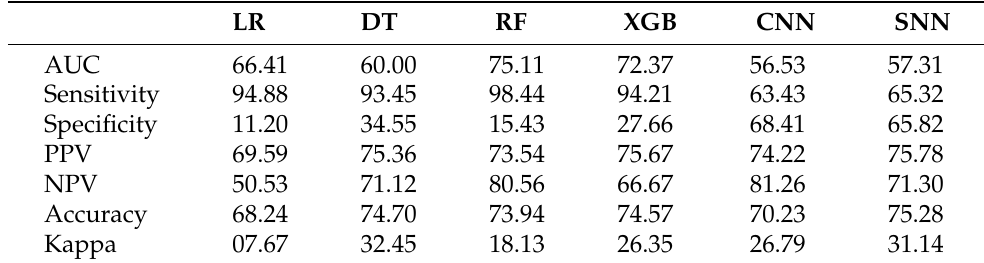
Table 6. Model performance comparison for risk